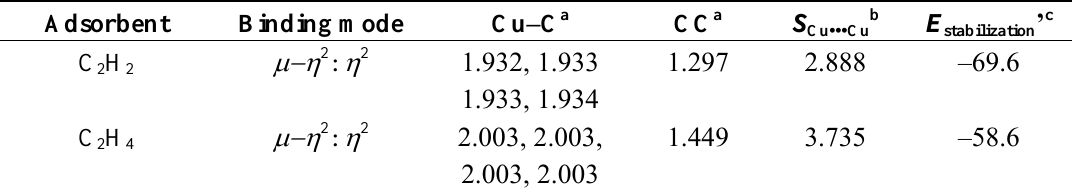
Table 5. Key parameters of the optimized structures of an unsaturated hydrocarbon adsorbed onto a dicopper active center bound to a small zeolite